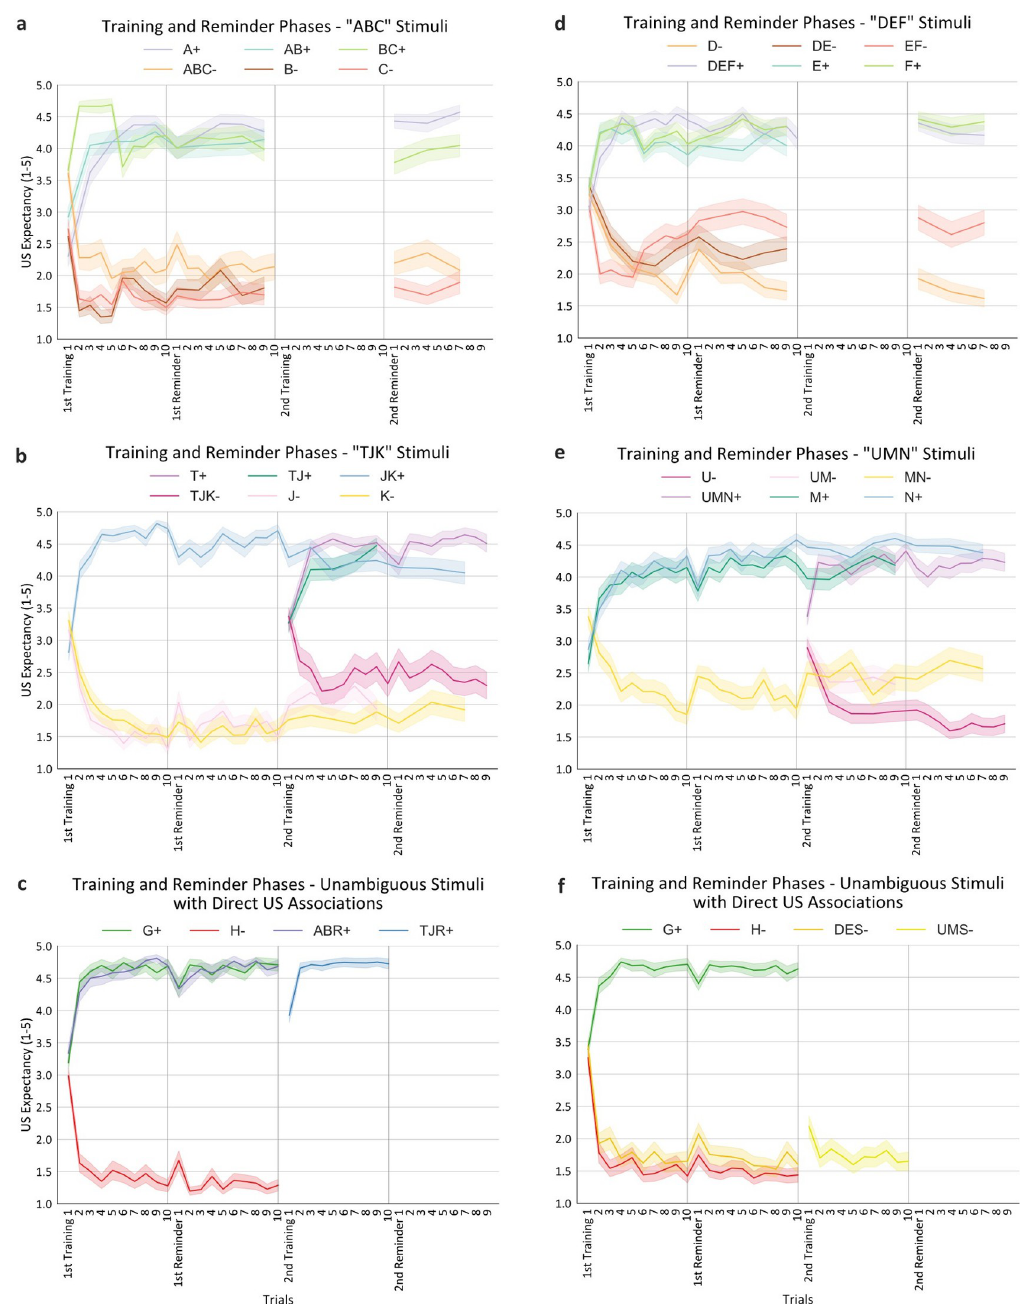
Fig 3. Experiment 1 and 2 Training Results. a, b, c) Experiment 1 Training results generally reflect direct CS/US associations, 1 st -order positive occasion setting, and 2 nd -order negative occasion setting. d, e, f) Experiment 2 Training results generally reflect direct CS/US associations, 1 st -order negative occasion setting, and 2 nd -order positive occasion setting. Congruent conditions/panels are displayed horizontally between experiments. Results in both experiments showed that participants correctly learned which stimuli were (non)reinforced. Error bands reflect standard error. Generally, “cool” colors (blues, greens, purples) indicate hypothesized higher values, whereas “warm” colors (reds, oranges, yellows) indicate hypothesized lower values. Additionally, because not all stimuli were trained in every phase of the experiment (e.g., the “ABC” and “DEF” stimuli were not trained during 2 nd Training), there are some empty spaces in the graphs of stimuli being shown either earlier or later in the experiment (e.g., G+ and H- were trained in the first half of the experiment). The reason that trial numbers vary between stimuli is to balance thoroughness of training and concision. During reminder phases, we wanted to remind participants of the most critical trial types relevant for the upcoming transfer test. For example, J- was not in the 2 nd